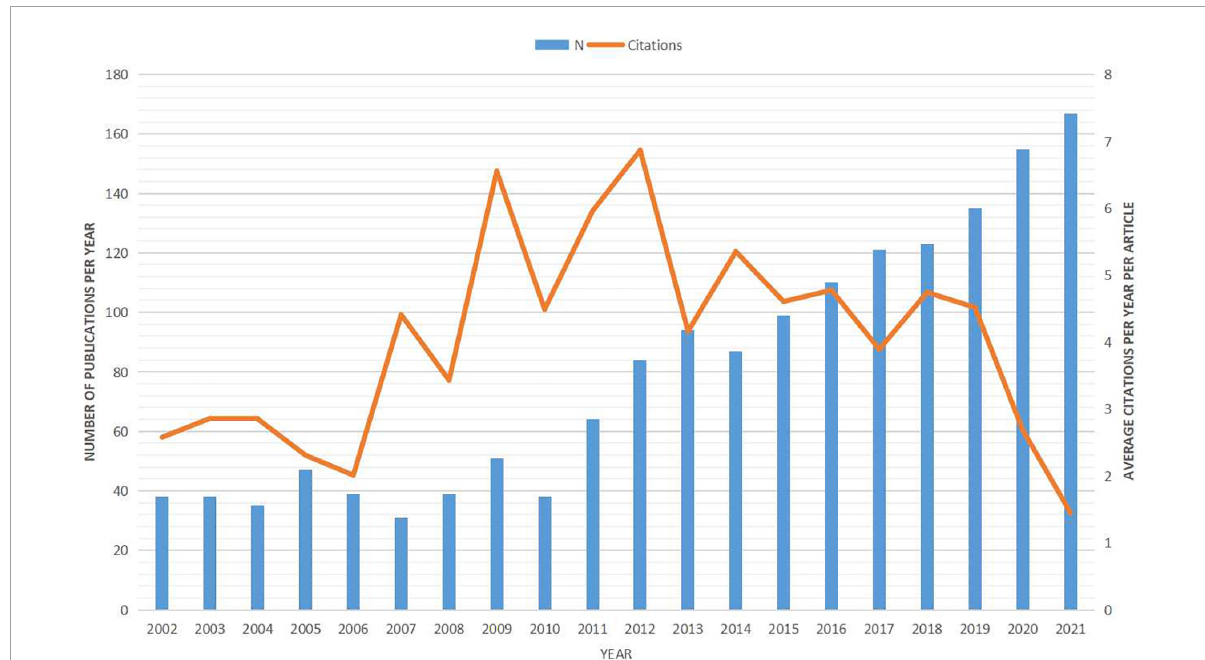
FIGURE1 Number of annual publications on the habenula from 2002 to 2021. Bars represent the annual publication number (left) and line represents the average citation number per year per documents